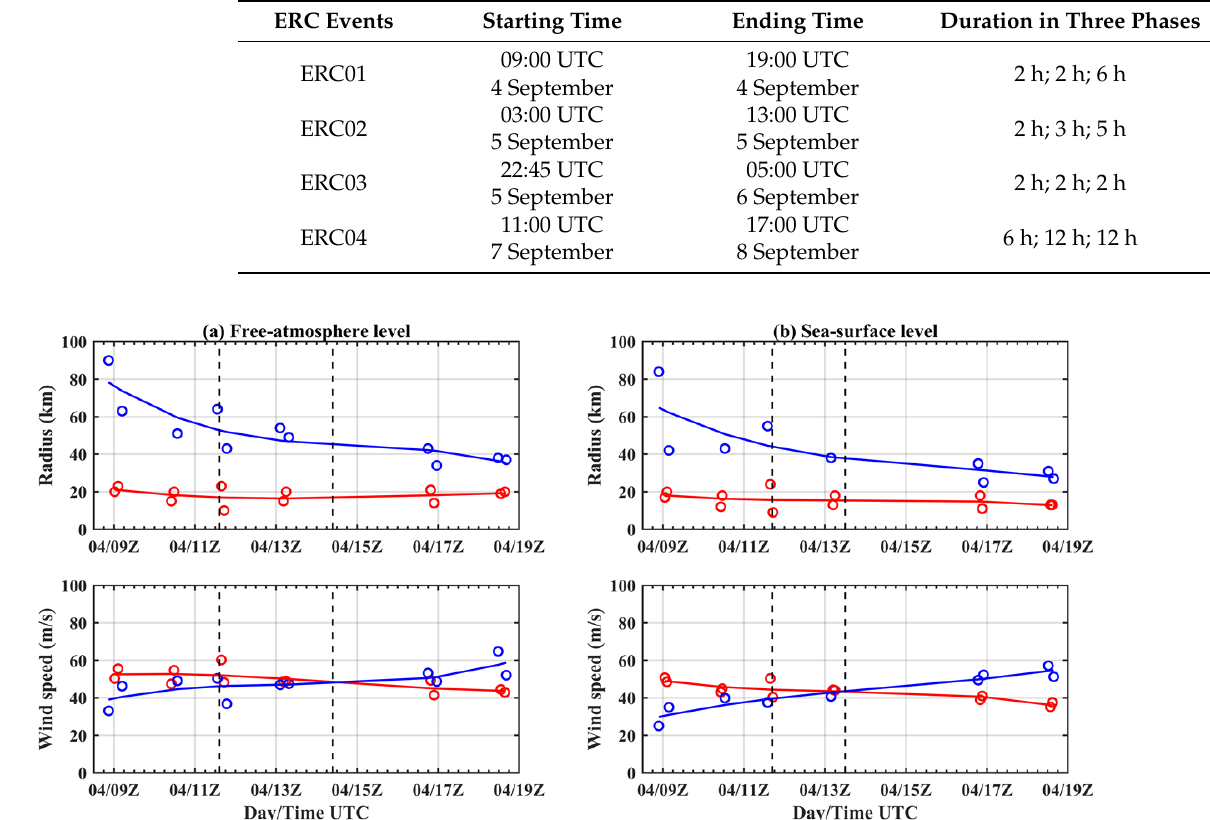
Figure 6. The evolution of wind profile parameters in ERC01 at the ( a ) free-atmosphere level and ( b ) sea-surface level. The top panel in each subfigure denotes the evolution of radii parameters r 1 (red circles) and r 2 (blue circles). The bottom panel in each subfigure denotes the evolution of intensity parameters v 1 (red circles) and v 2 (blue circles). Each time series of wind profile parameters was determined with a third-order polynomial best fit (solid lines). Vertical dashed lines separate phases of the ERC in terms of the evolution of intensity parameters.